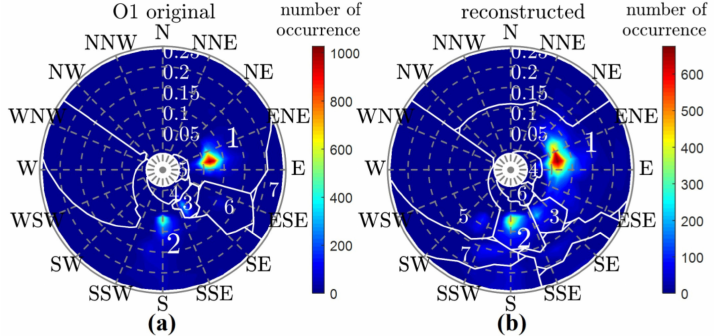
Figure 7. Groups identified at check point O1: ( a ) partition groups identified from the simulation with original boundaries, and ( b ) partition groups identified from the simulation with reconstructed boundaries. The f – θ spectral space is presented in polar coordinates, the number of occurrences of partition peaks in each f – θ cell is indicated by the colors, groups labeled 1–7 are ordered from large to small based on the peak-occurrence number, and the boundaries of the groups are depicted by the white